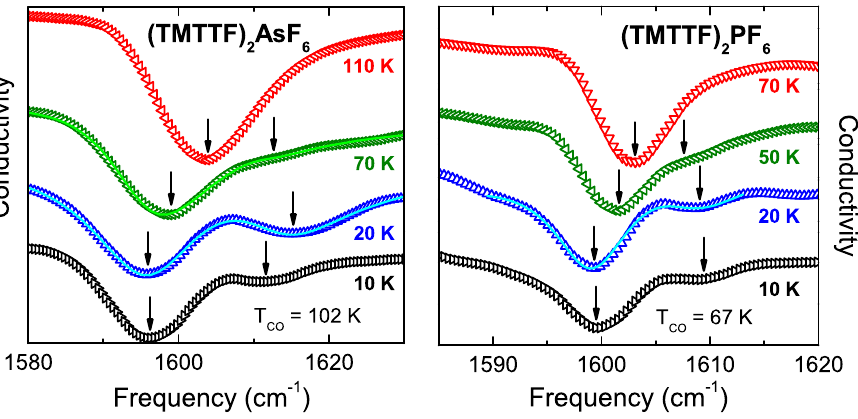
Figure 11. Mid-infrared conductivity σ polarized parallel to the molecular stacks ( E (cid:107) a ) in the spectral region of the emv coupled totally symmetric intramolecular ν curves are displaced by a constant factor to avoid overlap. The arrows indicate the positions of the antiresonance